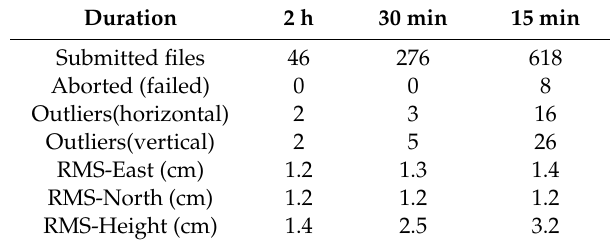
Table 2. Statistics of OPUS solutions for campaign surveys at the benchmark.